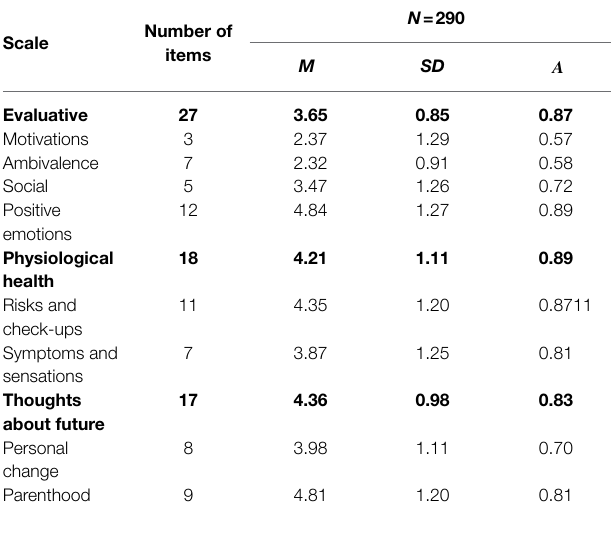
TABLE 2 | Means, standard deviations, and reliabilities of the scale